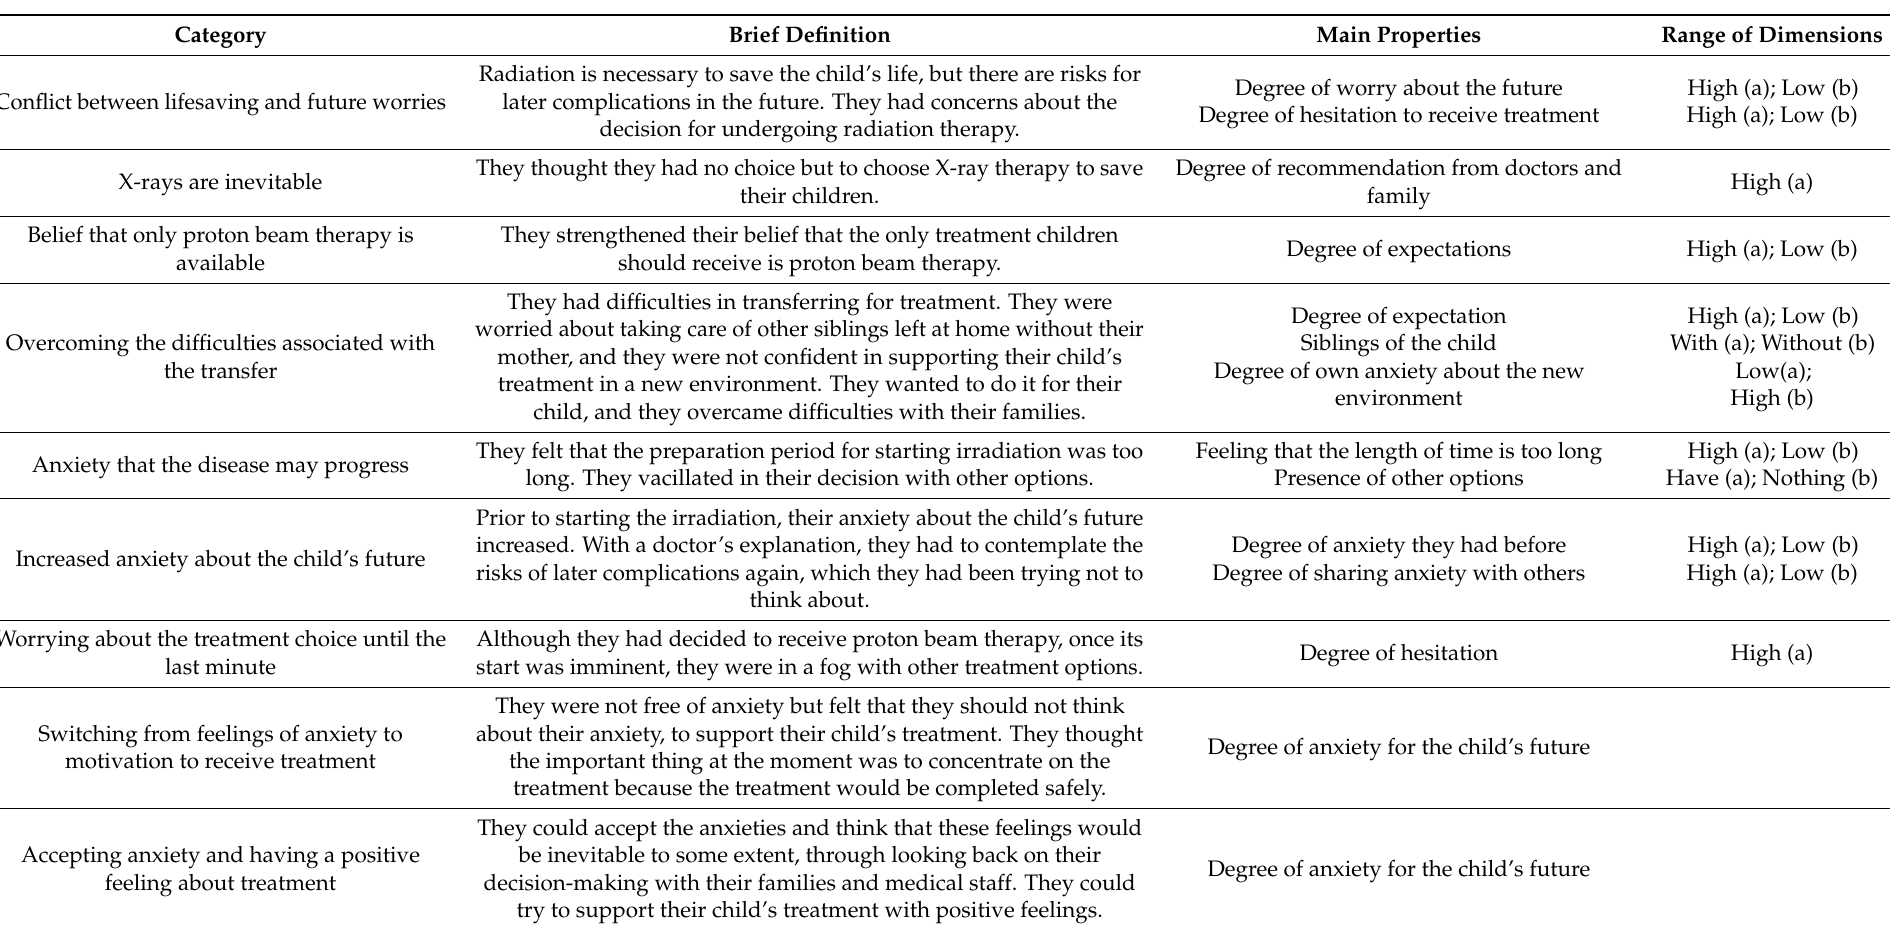
Table 2. Categories of “Increased anxiety about the children’s future” and their